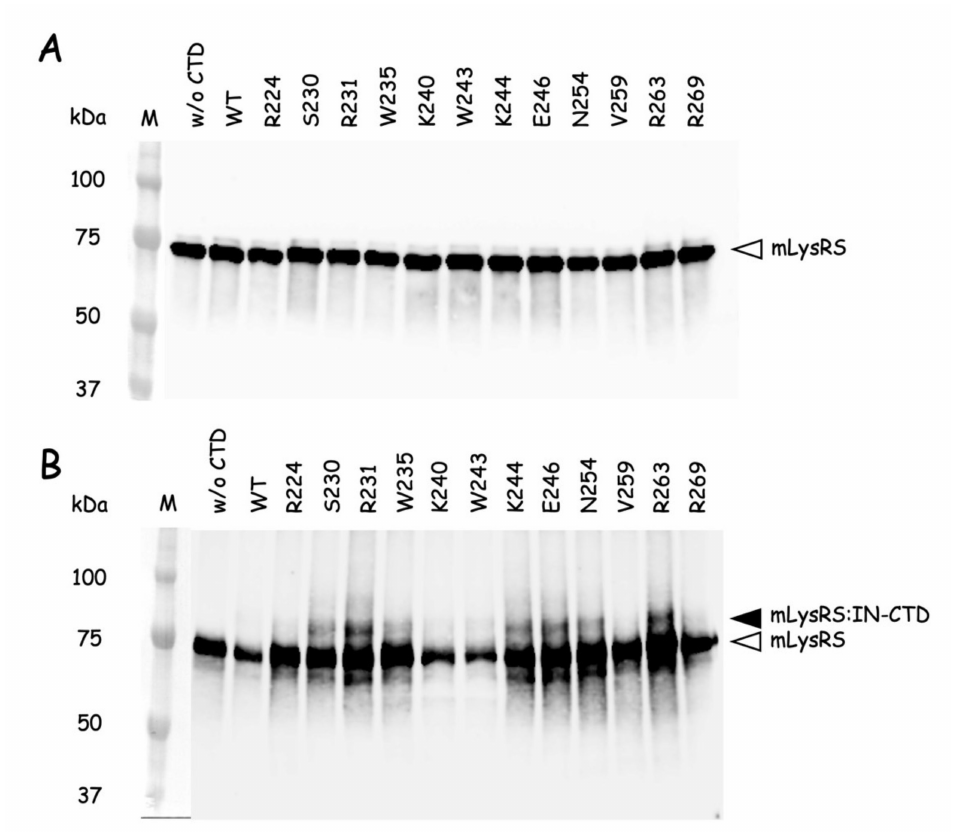
Figure 6. Cross-linking of the p Bpa-containing IN-CTD222 variants with mLysRS. Wild-type IN-CTD222 (WT) or IN-CTD222 containing p Bpa inserted at di ff erent positions (R224 to R269) were incubated at a monomer concentration of 1 µ M with mLysRS (dimer concentration of 250 nM) and exposed to UV light at 365 nm for 90 min. Samples recovered before ( A ) or after ( B ) exposure to UV were analyzed by SDS-PAGE and western blotting using anti-LysRS antibodies. The lanes containing the stained size-marker are added on the left (in kDa). The migration level of mLysRS (68 kDa) and of the polypeptide corresponding to an expected cross-linked species containing one monomer of IN-CTD222 and one monomer of mLysRS (79 kDa) are indicated by a white and black arrowhead, respectively. This experiment is the representative of two independent